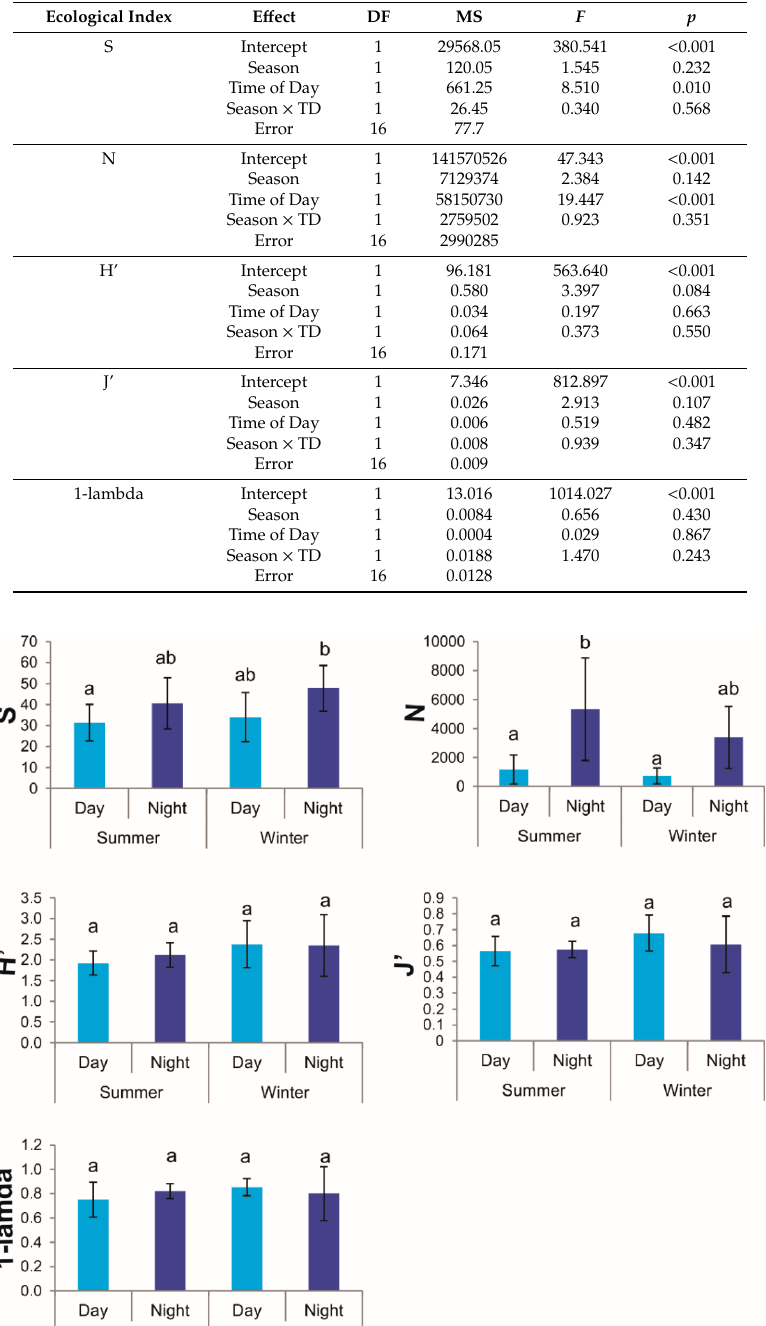
Table 1. Results of General Linear Models ( α = 0.05) on data of five ecological indices of decapod diversity (S: species richness; N: abundance; H’: Shannon–Wiener’s diversity; J’: Pielou’s evenness; 1-lambda: Simpson’s dominance) in two seasons (summer 1995, winter 1998) and two times of the day (day, night) in seagrass meadows of the Puerto Morelos reef lagoon (N = 5 sites per season and time of day).